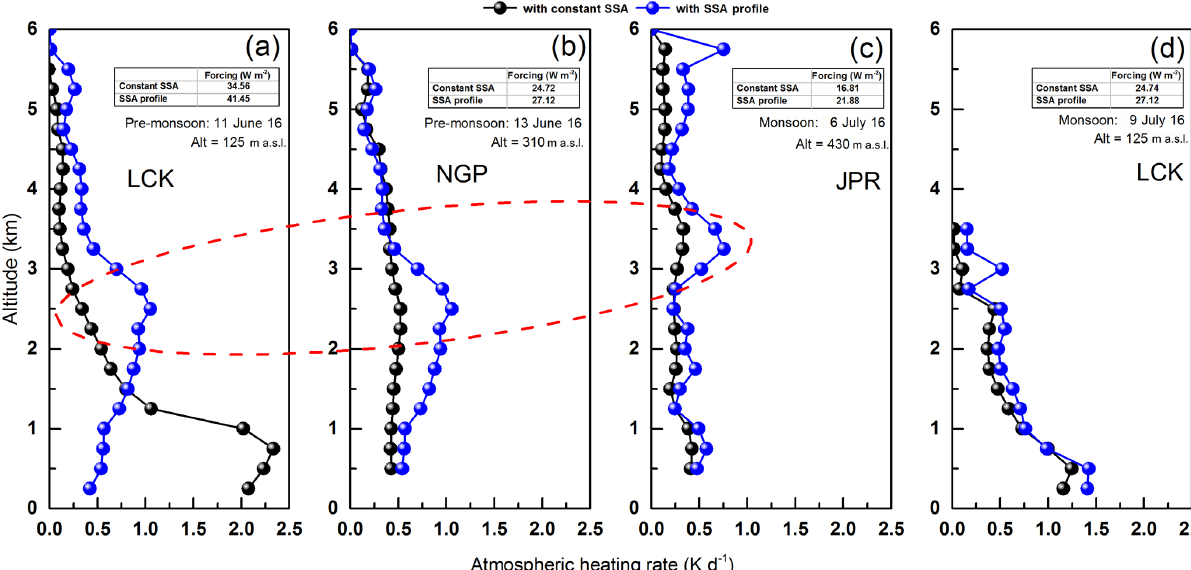
Figure 9. Equivalent heating profiles (corresponding to local noon) for central IGP (a) and central India (Nagpur, b ) just before the monsoon onset and profiles during the active monsoon phase in the western IGP (Jaipur, c ) and central IGP (Lucknow, d ). The black lines joining the black spheres represent the heating rate profile estimated using altitude-resolved extinction coefficients and columnar SSA, for the realistic atmosphere (measured pressure, temperature and water vapour) in the RT computation, while the blue lines joining the blue spheres represent the heating rate profile altitude-resolved SSA values, used in place of columnar values. The occurrence of the elevated layers of enhanced aerosol heating of the atmosphere is clearly seen in the latter case, emphasizing the importance of using realistic SSA profile. It is also interesting to note that the enhanced heating occurs at cloud layer